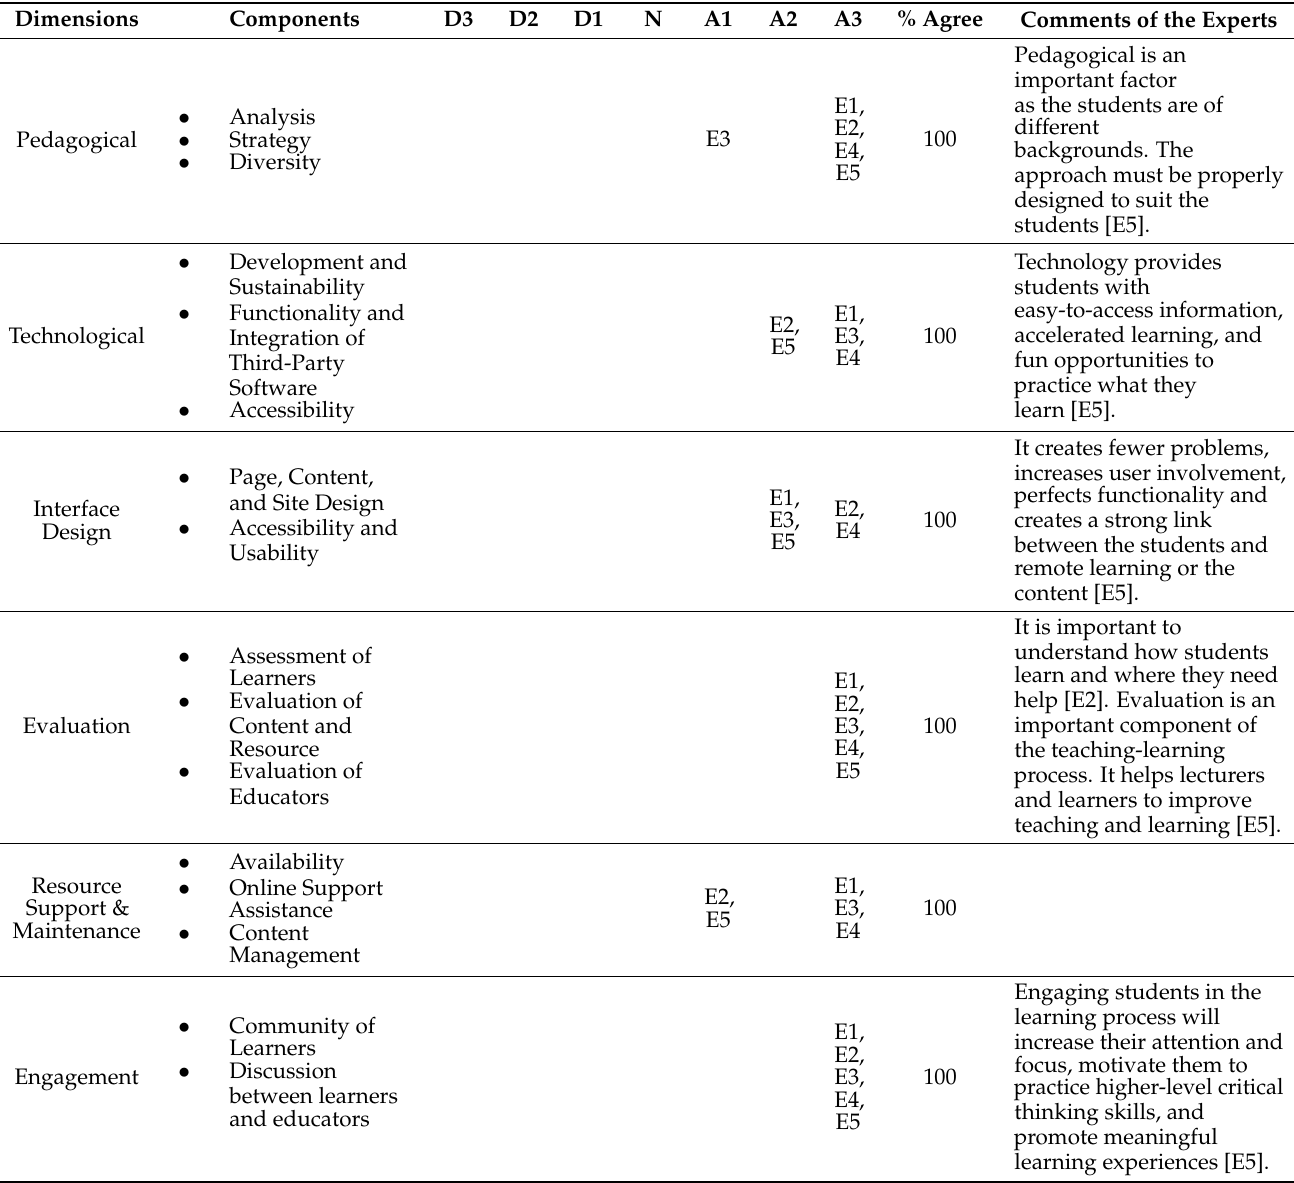
Table 4. Frequency Count Analysis of the C19MOOC